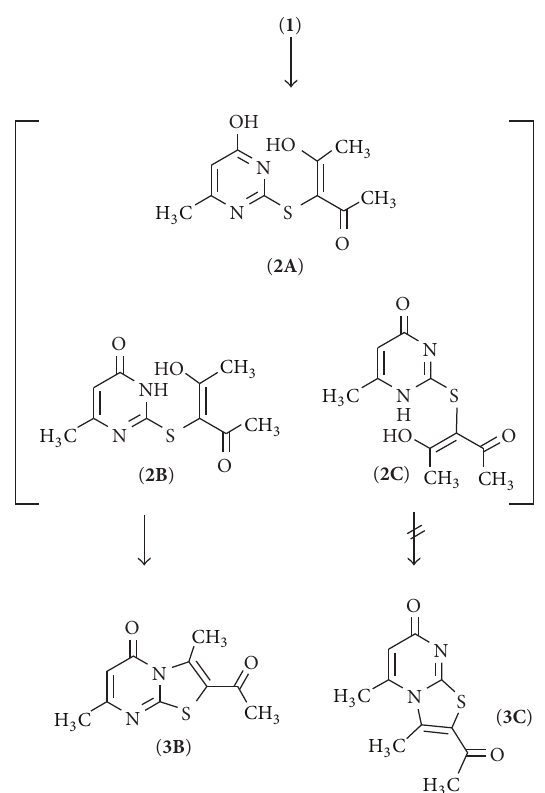
Scheme 2: Synthesis of 2-acetyl-3,7-dimethyl-5H-thiazolo[3,2-